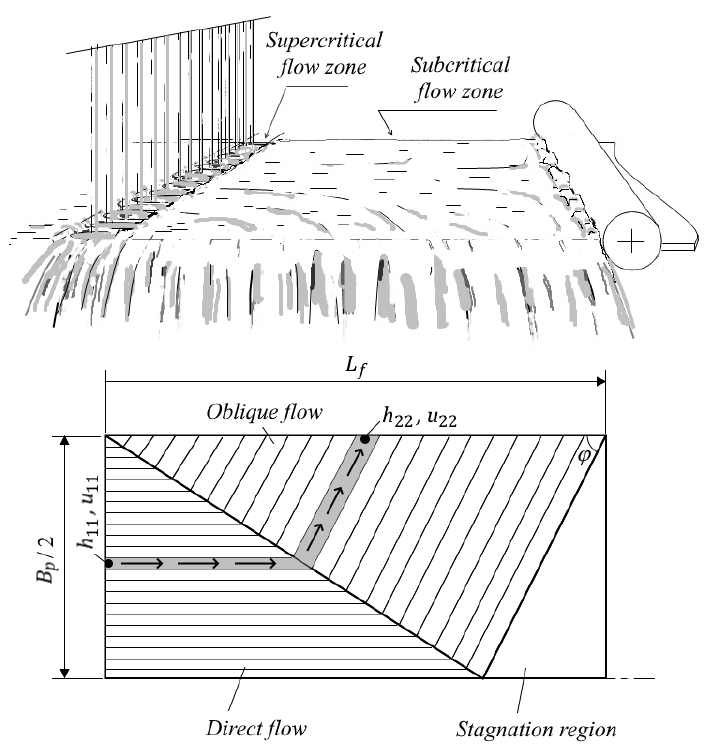
Figure 7. Schematic explaining the basic idea of calculating the parameters of the subcritical water flow zone by conventionally dividing this zone into three regions: direct flow, oblique flow and stagnation region. The arrows show the direction of water flow in the median streamline. The designations are in the text.